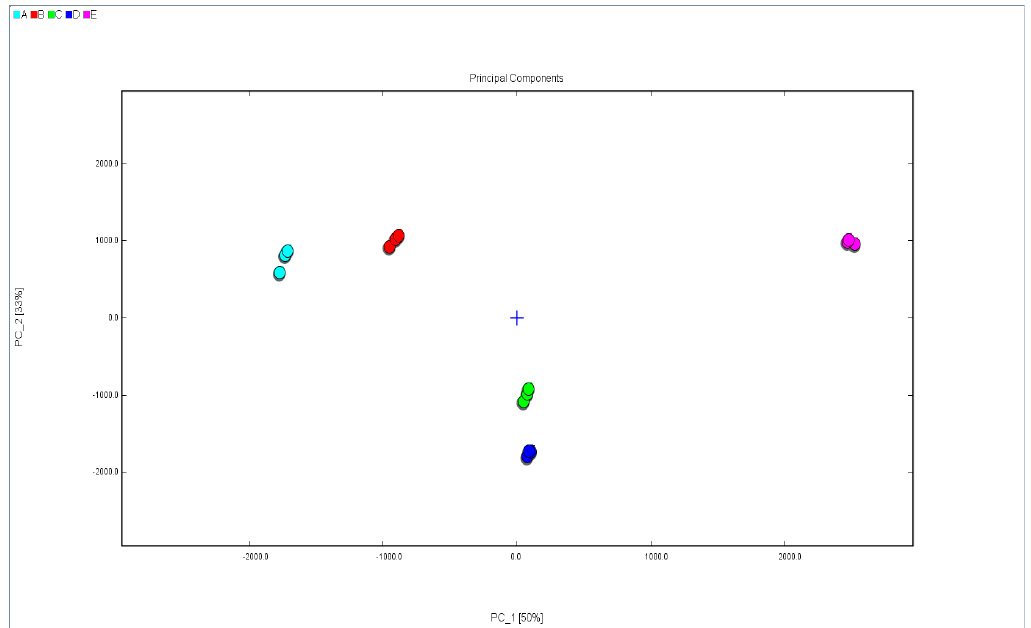
Figure 3. PCA diagram of walnut oil from five different varieties((A: Xin2; B: 185; C: Xinfeng; D: Xin’guang; E: Zha343)).